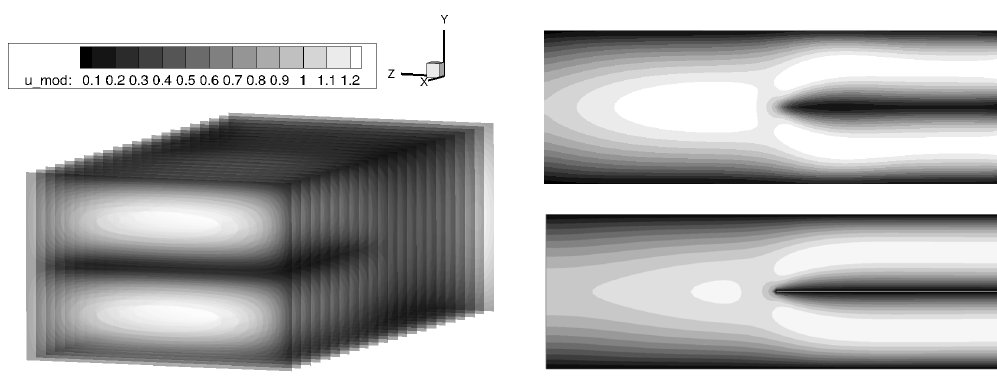
Figure 2. Distribution of the velocity modulus in the general view (left) and at the Z = 1 . 5 plane, calculated by the double potential method (top right) and Ansys CFD (bottom right)